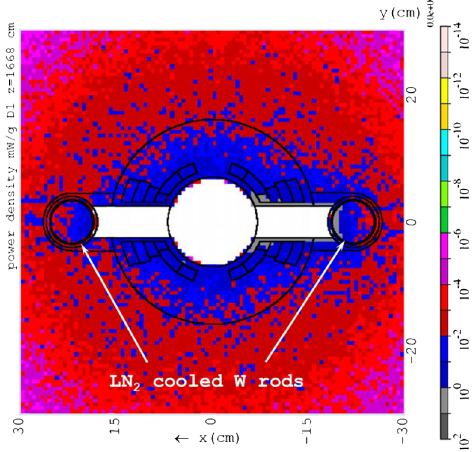
FIG. 7. Power density ( mW = g ) in B1 dipole for case